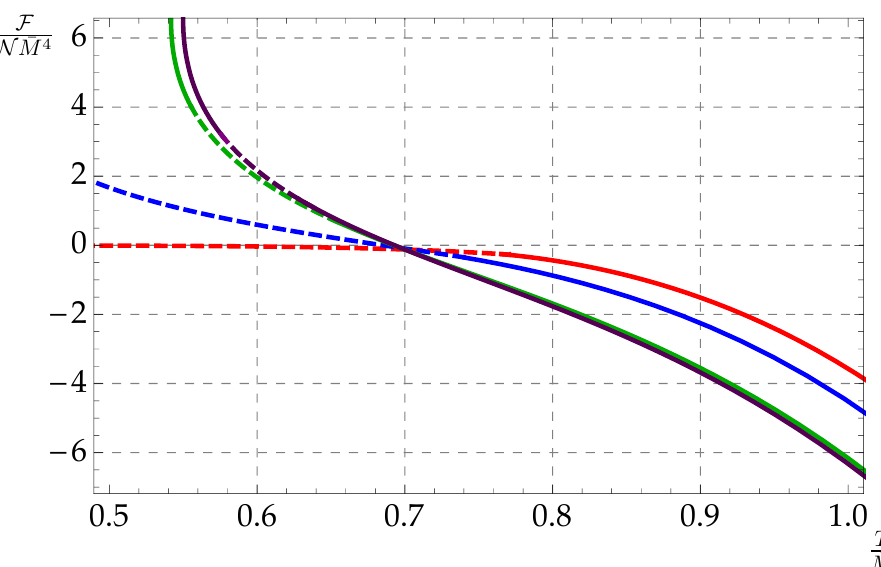
Figure 7 . Free energy density F = N (cid:22) M 4 as a function of T= (cid:22) M . Red, blue, green, and purple curves (bottom to top on the left) correspond to b= (cid:22) M 2 = f 0 ; 2 ; 3 : 3 ; 3 : 4 g respectively. The dashed segments correspond to Minkowski embeddings, while the continuous segments correspond to black hole embeddings. The (cid:12)nite term is (cid:12)xed at C 2 =